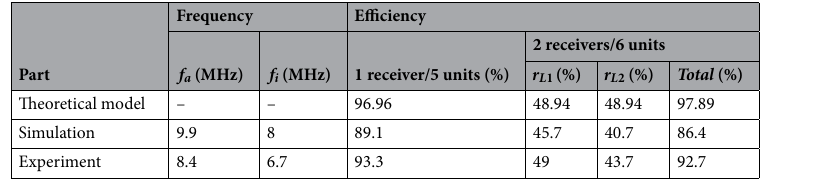
Table 2. Performance